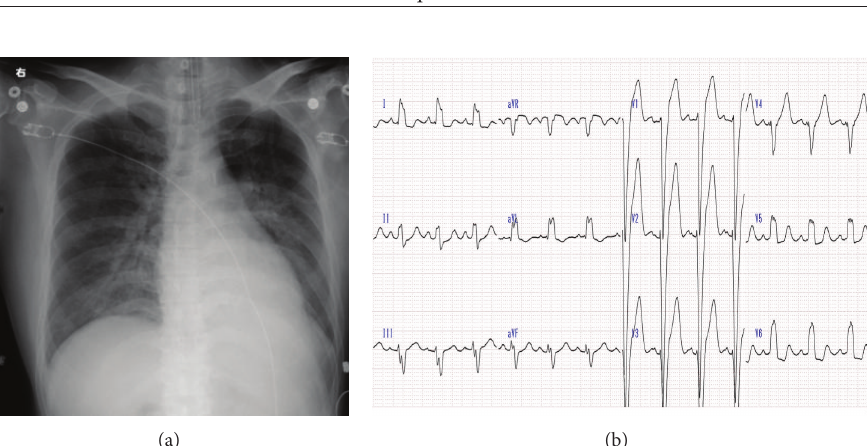
Figure 3: (a) Chest X-ray on admission demonstrating severe cardiomegaly. (b) Electrocardiogram on admission showing wide QRS pattern and